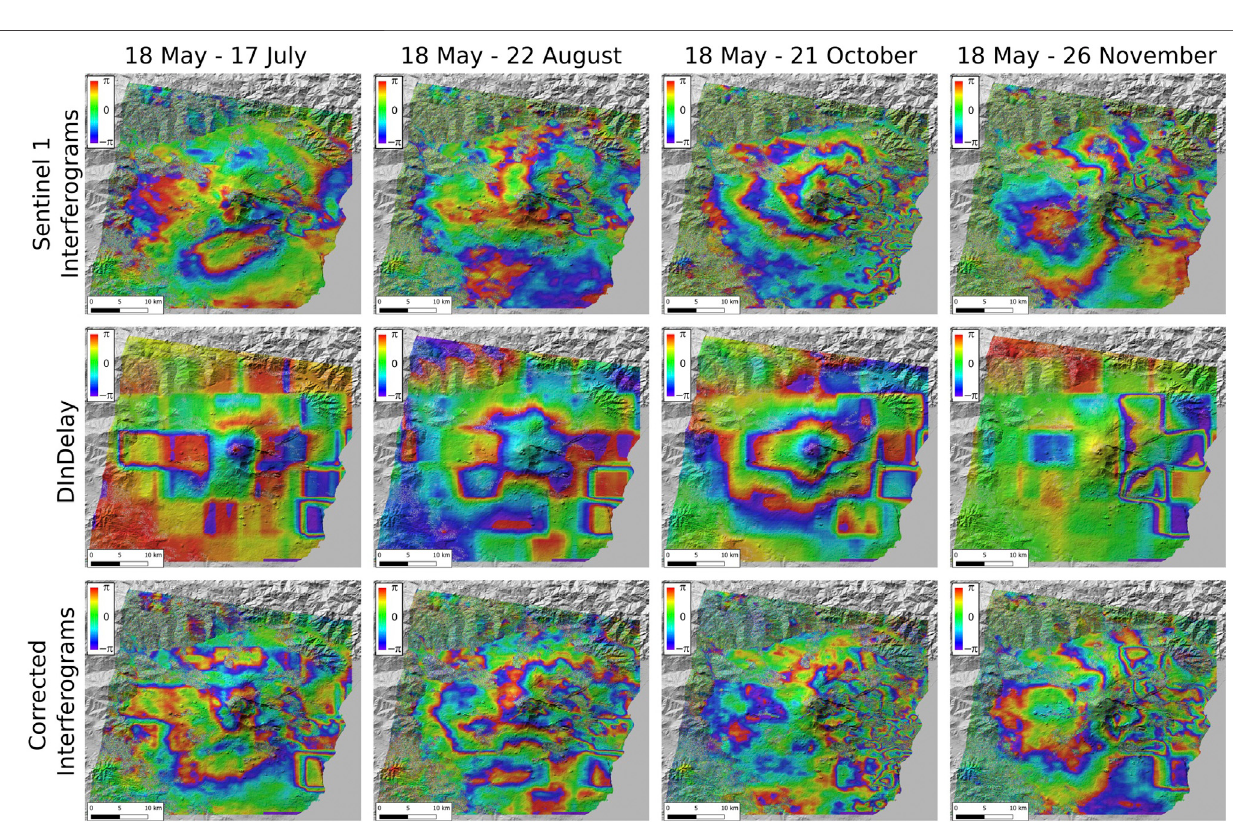
FIGURE 10 | Sentinel-1 interferograms, DInDelay (Differential Interferograms Delay) and Sentinel-1 corrected interferograms. On the fi rst row the DInSAR data are shown, on the second and third rows the corresponding DInDelay and corrected interferograms. All the images are shown in phase ( − π , π ; 2 π phase corresponds to 28 mm). In the 18 May – 26 November interferogram the high-frequency atmospheric perturbation is in the northeastern fl